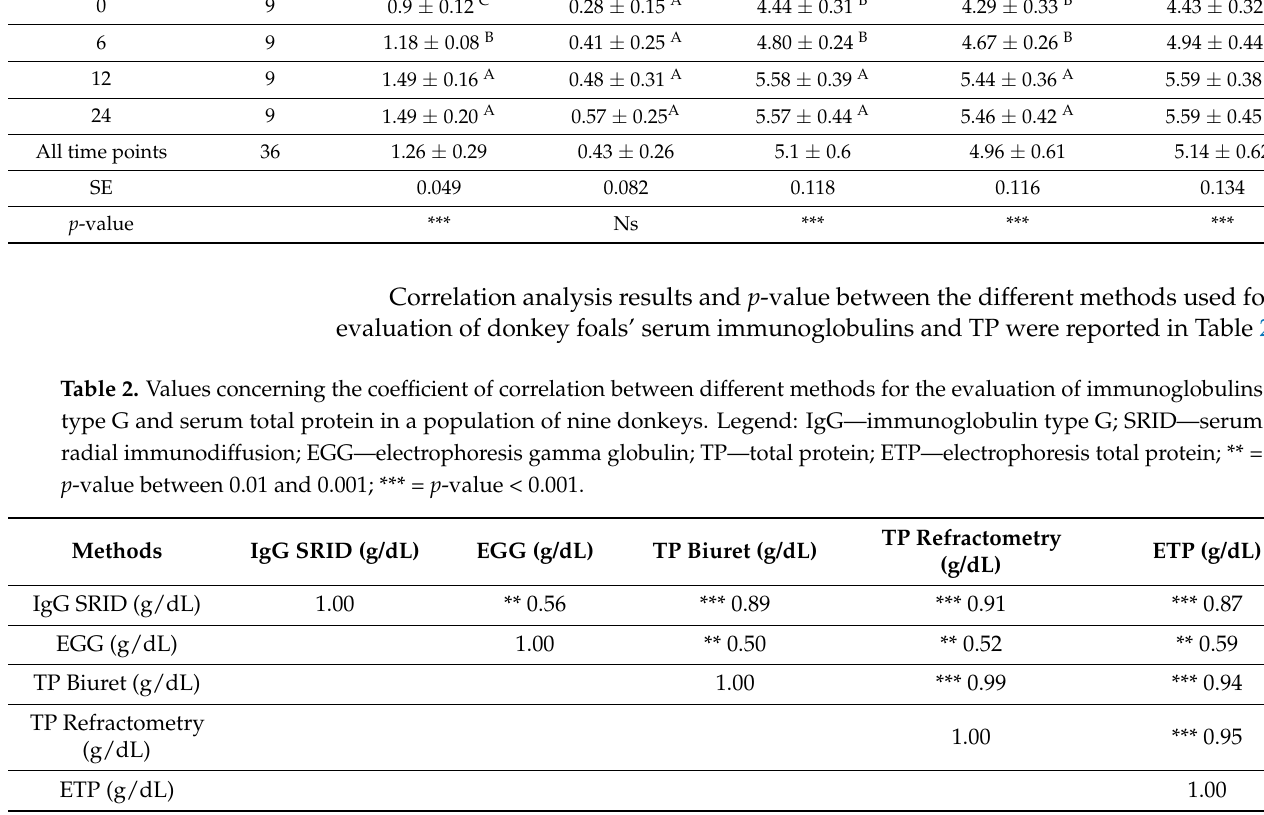
Table 1. Results concerning serum IgG concentrations or total protein concentration evaluated by different methods, expressed in mean and standard deviation, in a population of nine donkey foals (total of 36 samples) at different collection time. Legend: IgG—immunoglobulin type G; SRID—serum radial immunodiffusion; EGG—electrophoresis gamma globulin; TP—total protein; ETP—electrophoresis total protein. Legend: A (cid:54) = B (cid:54) = C p < 0.05 between values on the same column; *** = p -value < 0.001. Hours Post-Partum.